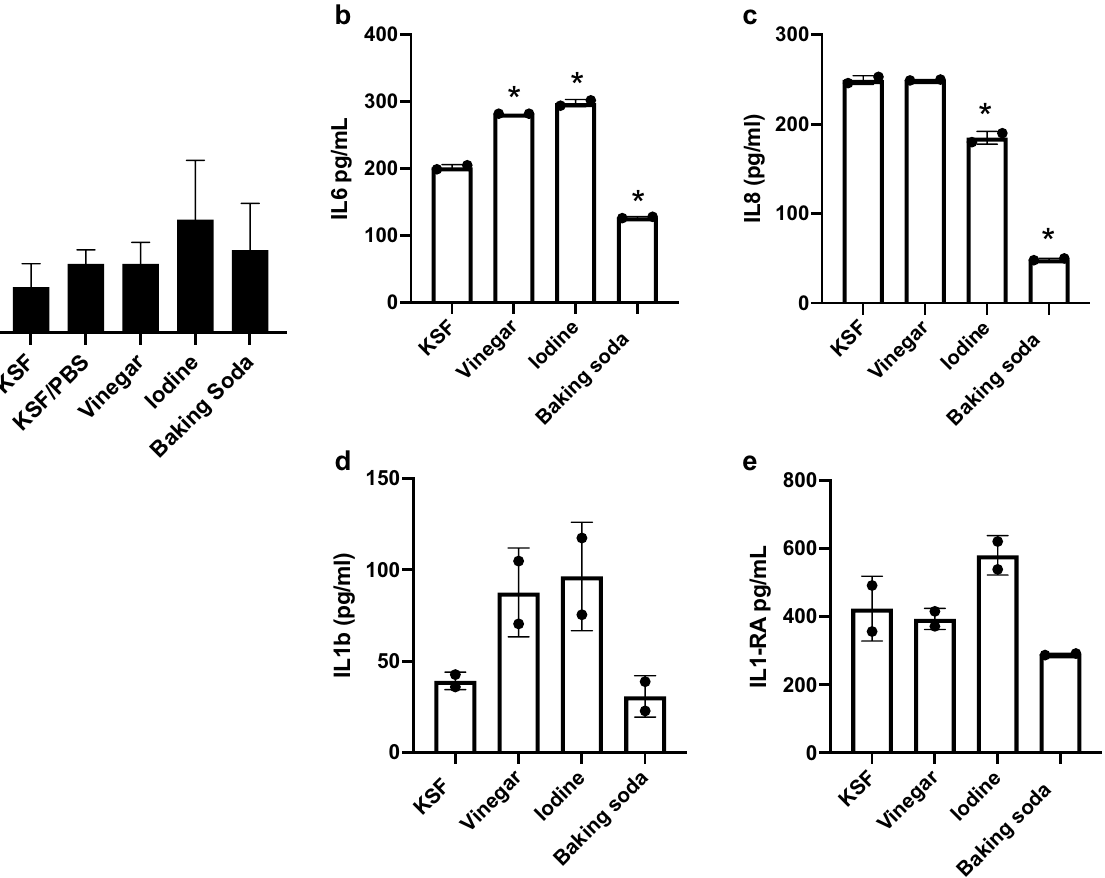
Figure 2. Impact of douching products on vaginal epithelial cells. An immortalized vaginal epithelial cell line was cultured with a 25% solution of douching product diluted in the cell culture medium for 1 h, followed by replacement with fresh media for 23 h. Cell death ( a ) was measured using an LDH assay and IL6 ( b ), IL8 ( c ), IL1β ( d ) and IL1-RA ( e ) were measured in supernatant by ELISA. Results are presented as mean ± SD from at least two separate